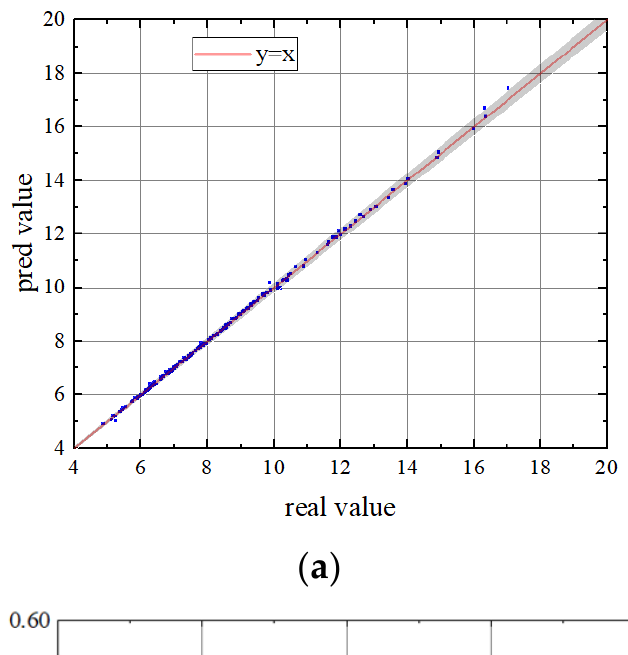
Figure 14. Mean axial flow force (( a ) Predicted value and true value; ( b ) relative error density dis- tribution).